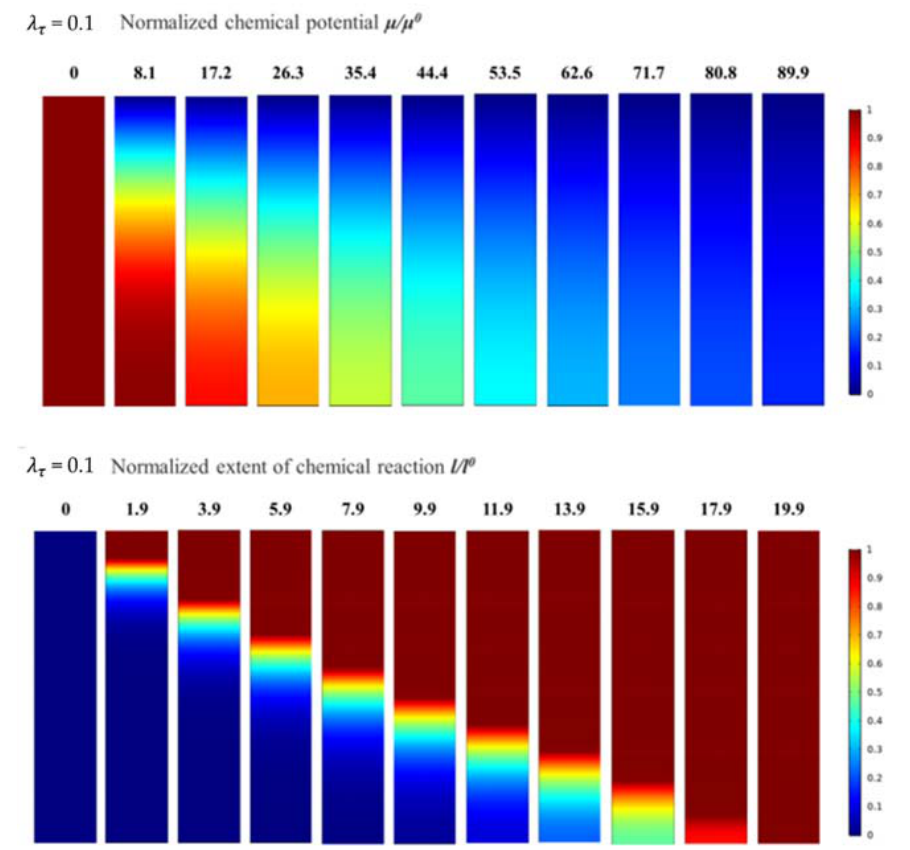
Figure 4. The evolution process of normalised chemical potential and normalised chemical reaction degree when λ (cid:2980) = 0.1.